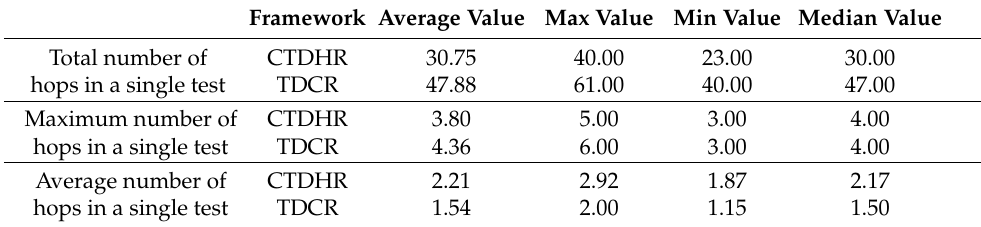
Table 5. Statistics on the stability of clusters and the number of clusters for CTDHR and